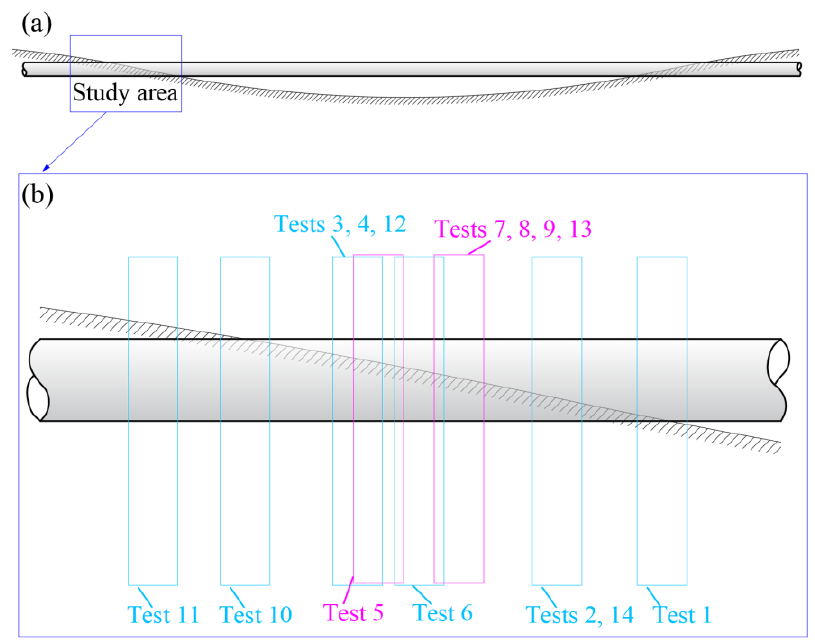
Figure 1. ( a ) Schematic diagram showing the touchdown section of a pipeline. ( b ) Simulation range of each experiment.